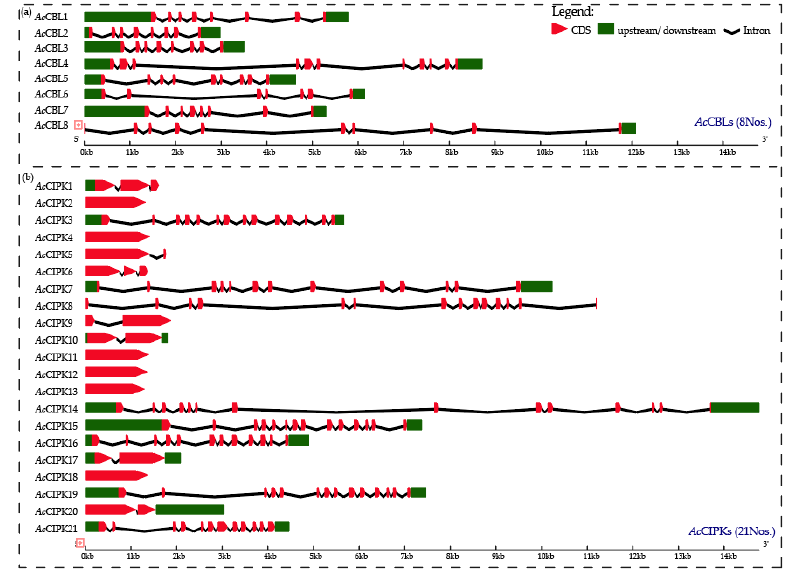
Figure 1. Exon-intron structure of pineapple CBL-CIPK genes. ( a ) Exon-intron structure of pineapple CBL genes ( b ) exon-intron structure of pineapple CIPK genes; green boxes indicate untranslated 5′- and 3′-regions; red boxes indicate exons; black lines indicate introns. Prefix ‘Ac’ indicates Ananas comosus.